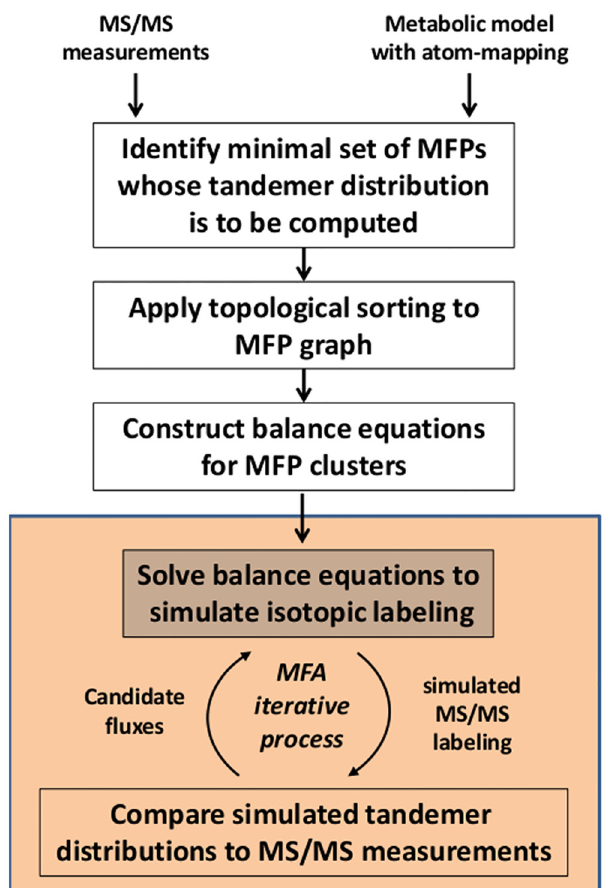
Fig 3. An outline of the tandemers approach. First, given MS/MS measurements and a metabolic model, a minimal set of MFPs is identified constructing an MFP graph. Second, MFPs are clustered and sorted and third, isotopic balance equations are formulated for each MFP cluster. Given a candidate flux vector, tandemer distributions are calculated by solving the set of isotopic balance equations.